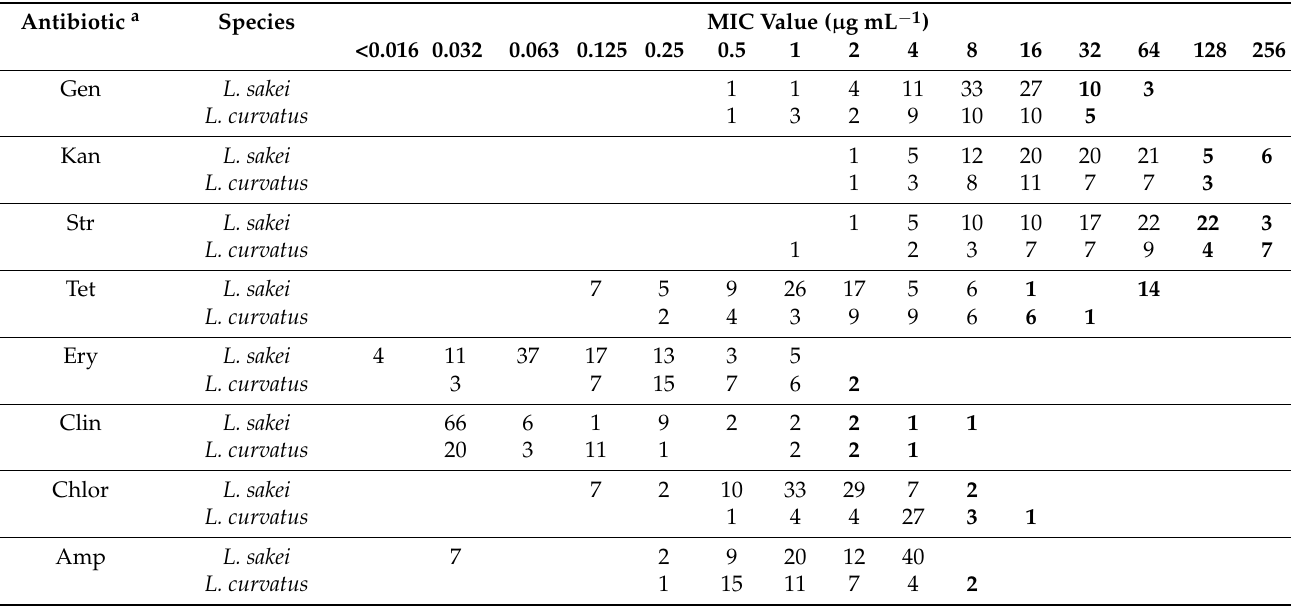
Table 3. Unimodal distribution of MICs for L. sakei and L. curvatus isolated biotypes. The resistant strains for each antibiotic are highlighted (bold and